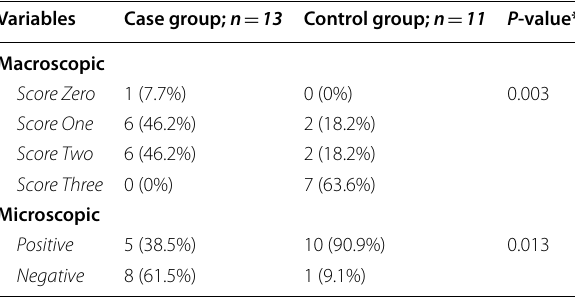
Table 2 Comparison of macroscopic and microscopic findings of subjects treated with captopril (case group) and subjects treated with normal saline (control group) based on arthrofibrosis